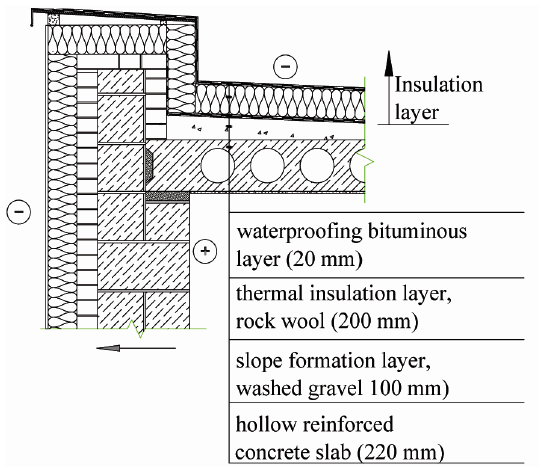
Fig. 5. Improvement of the thermal insulation layer (200 mm in width) on the roof of the building. The external insulation layer on walls is connected to the insulation layer on the roof